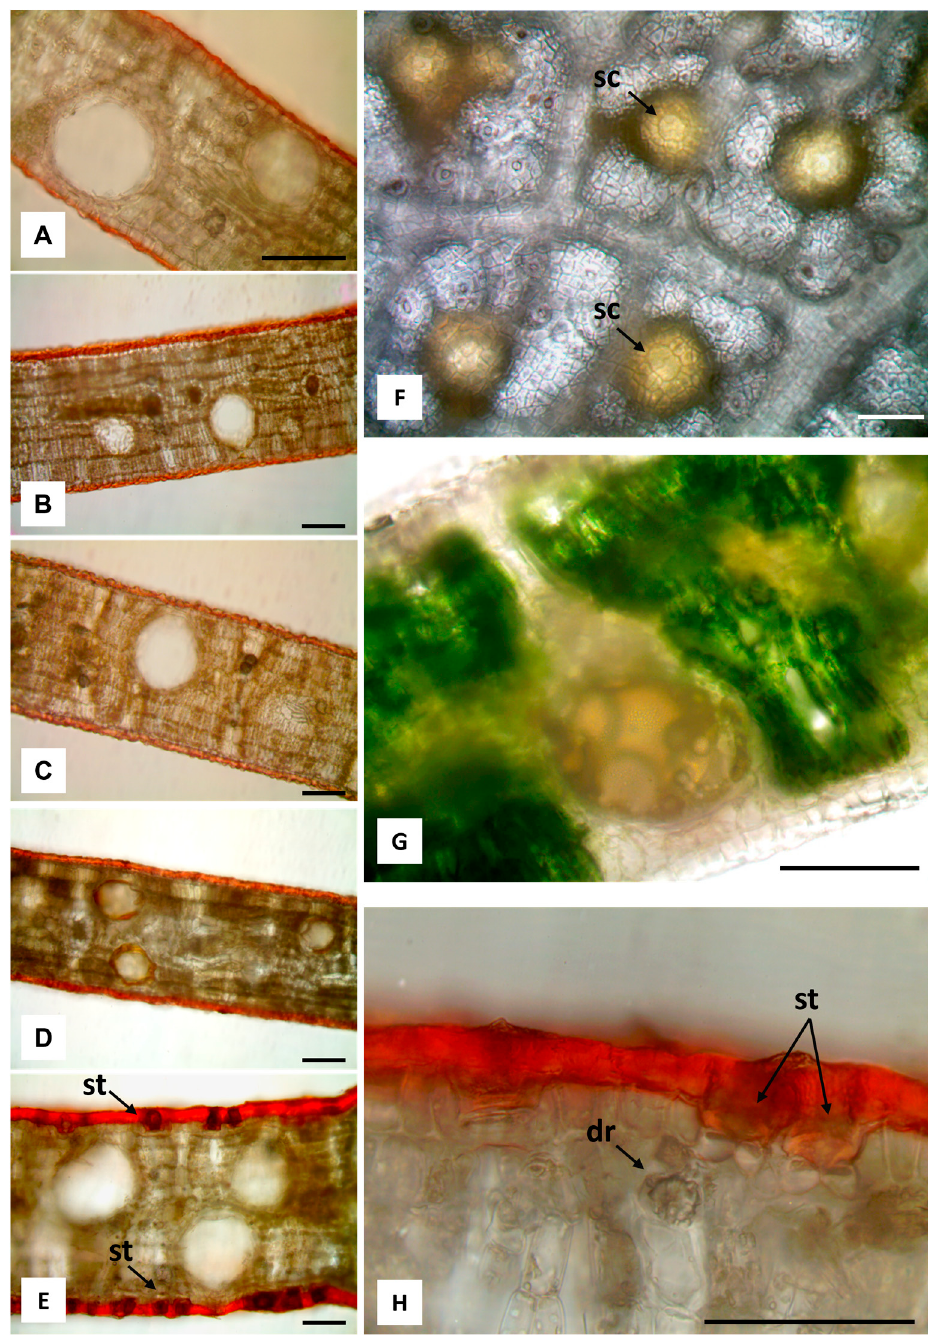
Figure 3. Light microscopy images. ( A–E ) Hand-made transverse leaf sections stained with Sudan III highlight the thick layers of cuticle and the secretory cavities spread in the mesophyll: E. alba ( A ), E. eugenioides ( B ), E. fasciculosa ( C ), E. robusta ( D ), E. stoatei ( E ). ( F , G ) Leaves of E. alba : abaxial surface after bleaching with sodium hypochlorite, showing bright yellow secretory cavities (sc), and their overlying cells (arrows) ( F ); transverse section showing a secretory cavity containing many drops of brownish yellow EO ( G ). ( H ) Transverse section of E. stoatei leaf stained with Sudan III, showing a thick cuticle, and stomata (st); a druse (dr) under the epidermis is also visible. 100 µ m bars.